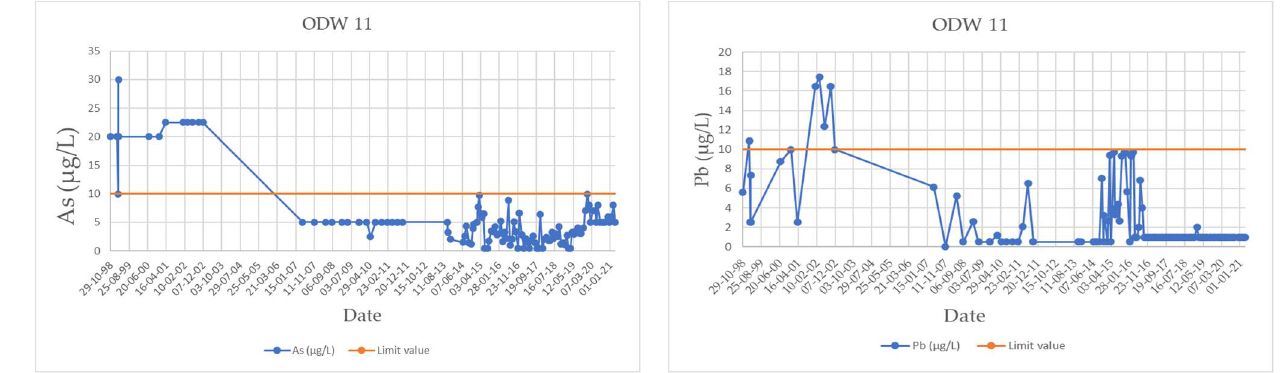
Figure 8. As and Pb in the ground waters vs. time within the old Olympias arsenopyrites concentrate storage area (ODW11 monitoring station).